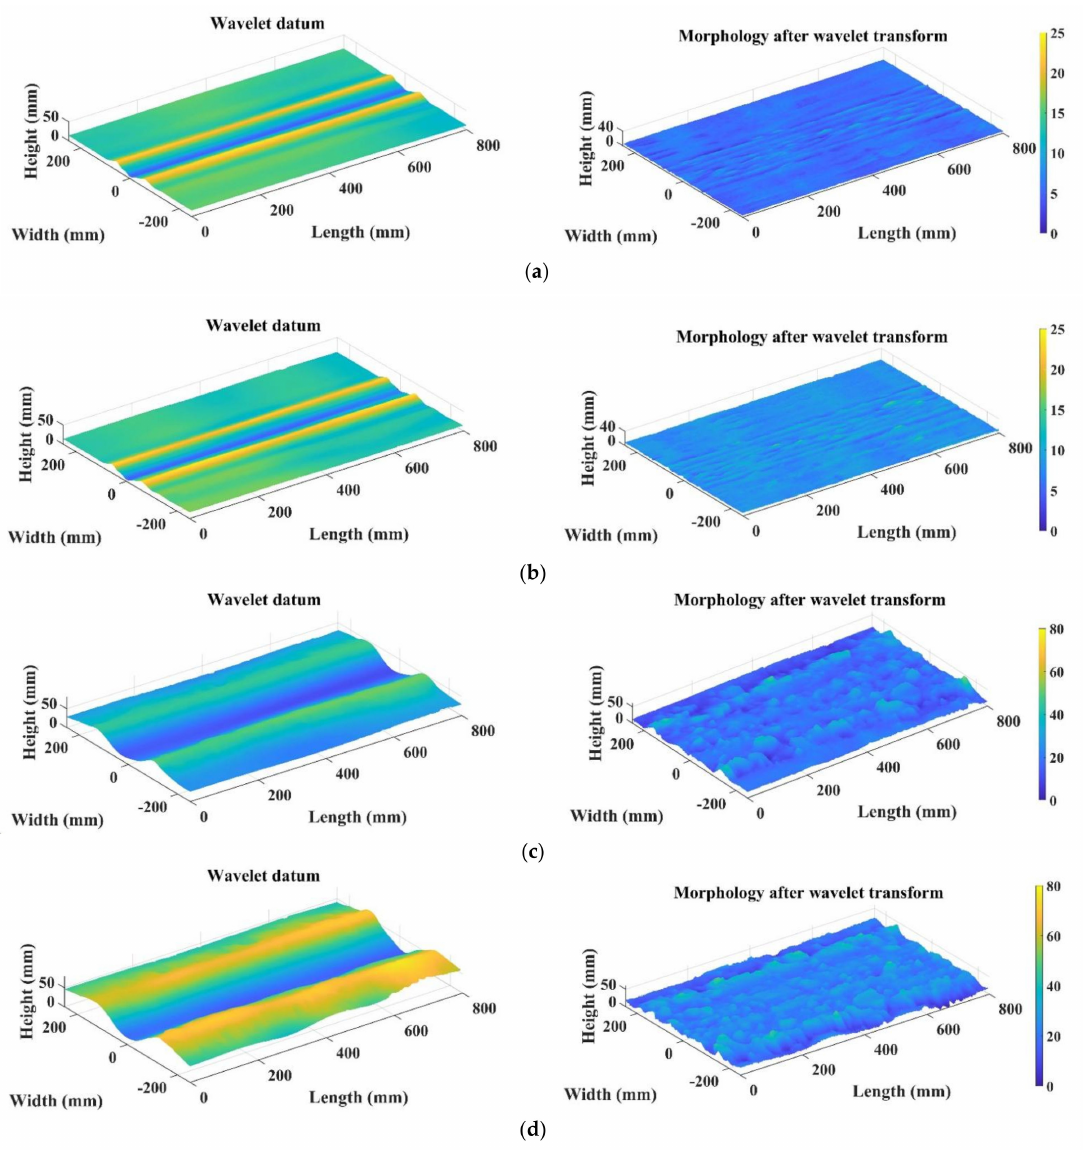
Figure 8. Wavelet datum and DEM after wavelet transform. ( a ) Ditching depth of 5 cm. ( b ) Ditching depth of 8 cm. ( c ) Ditching depth of 10 cm. ( d ) Ditching depth of 12